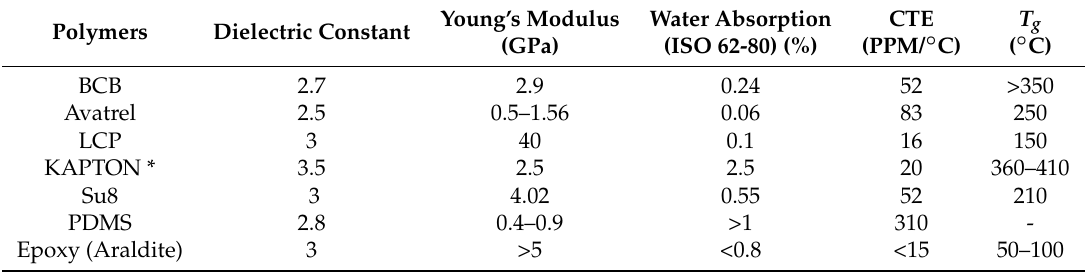
Table 2. Binder polymers for fabricating PMC cores to be used in high frequency applications. Polymers